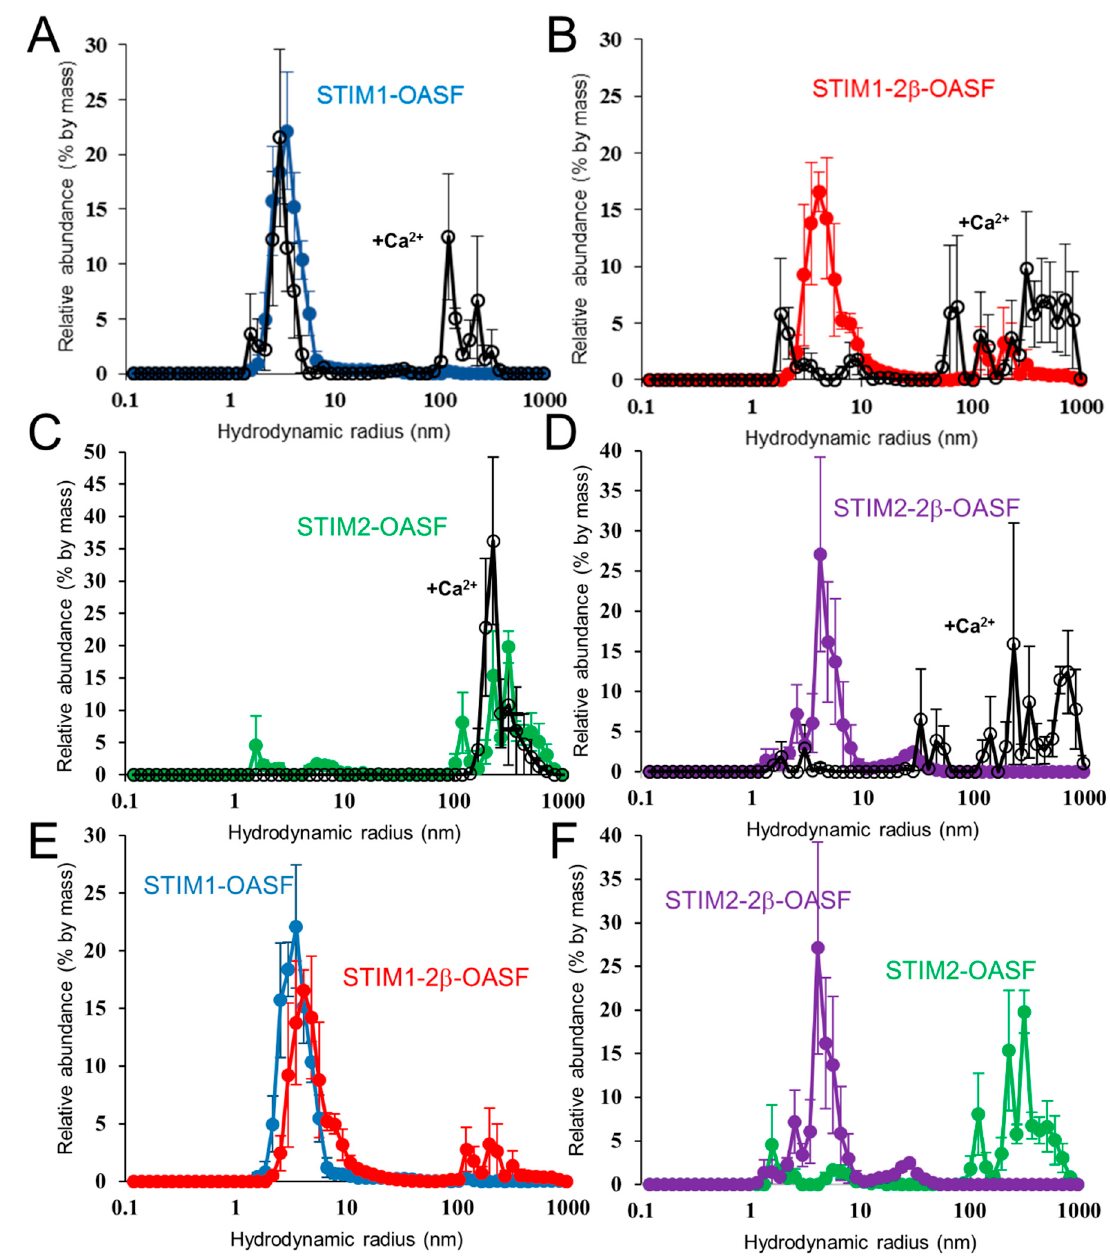
Figure 5. Hydrodynamic size distributions of STIM OASF proteins. ( A ) Distribution of hydrodynamic radii for STIM1-OASF. ( B ) Distribution of hydrodynamic radii for STIM1-2 β -OASF. ( C ) Distribution of hydrodynamic radii for STIM2-OASF. ( D ) Distribution of hydrodynamic radii for STIM2-2 β -OASF. In ( A – D ), the sizes are derived from the regularization deconvolution of the autocorrelation functions acquired using 0.5 mg·mL − 1 protein at 35 °C in the absence (colored circles) and presence of 25 mM CaCl 2 (open circles). ( E ) Direct comparison of the STIM1-OASF and STIM1-2 β -OASF size distributions in the absence of CaCl 2 . ( F ) Direct comparison of the STIM2-OASF and STIM2-2 β -OASF size distributions in the absence of CaCl 2 .